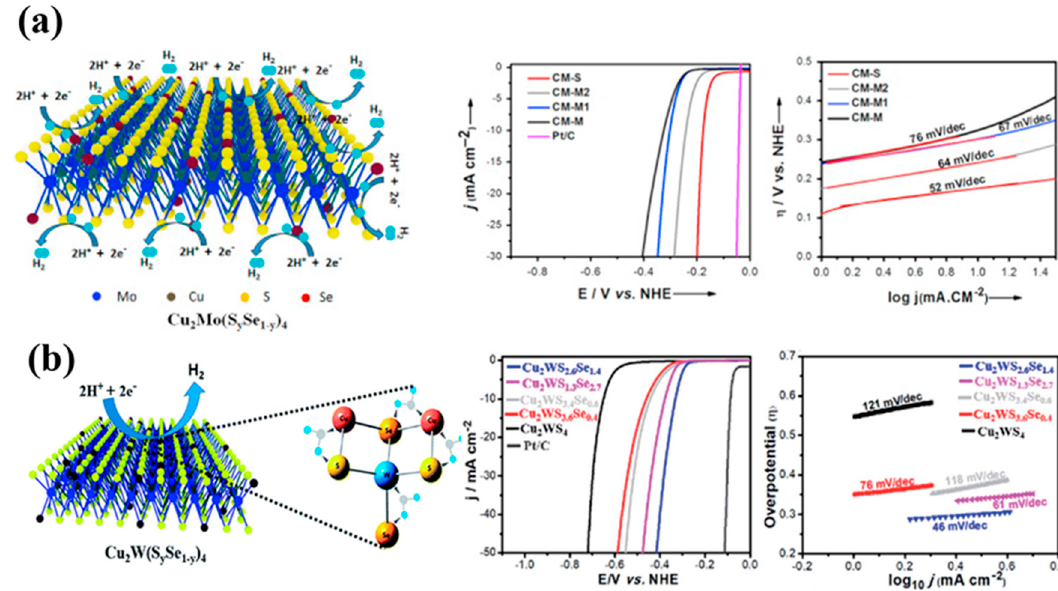
Figure 9. ( a ) Schematic illustration of HER activity on single layer Cu 2 Mo(S 1 − y Se y ) 4 and corresponding polarization curves and Tafel plots for single and multi-layer Cu 2 Mo(S 1 − y Se y ) 4 . Reprinted with permission from Reference [64], copyright (2016), Elsevier. ( b ) Schematic illustration of HER activity on Cu 2 W(S 1 − y Se y ) 4 and corresponding polarization curves and Tafel plots for Cu 2 W(S 1 − y Se y ) 4 . Reprinted with permission from Reference [137], copyright (2018), Royal Society of Chemistry.